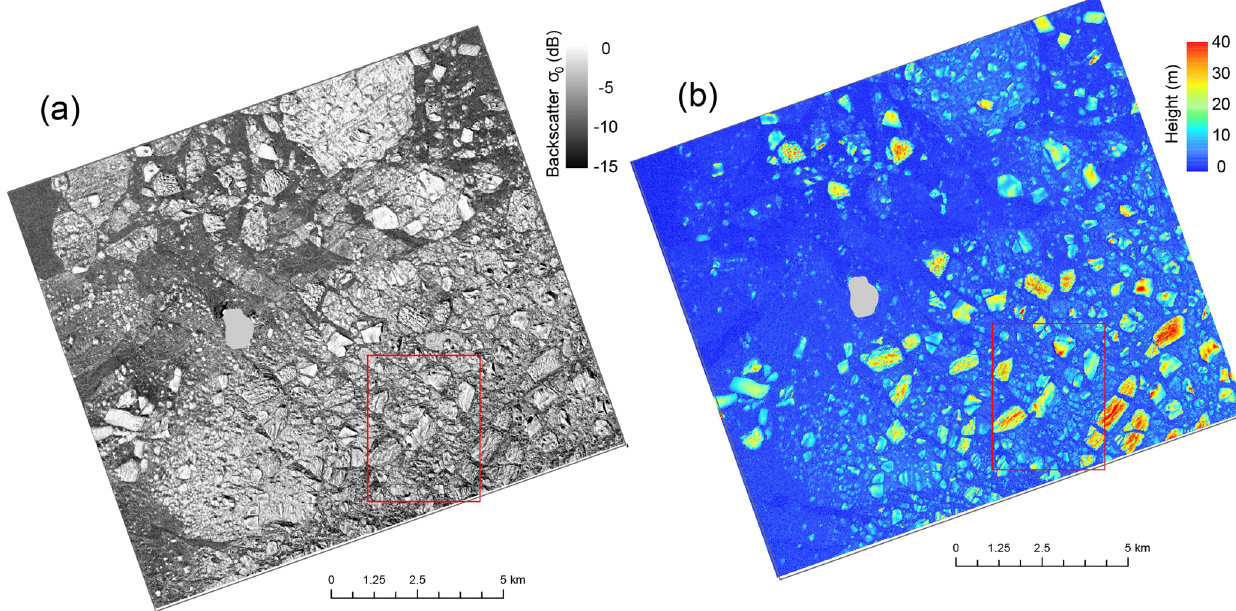
Figure 3. Cropped area of the TanDEM-X scene processed for backscatter intensity (a) and interferometric height (InSAR DEM) (b) . The red rectangle signifies validation area. Buffer Island is masked out in light gray.